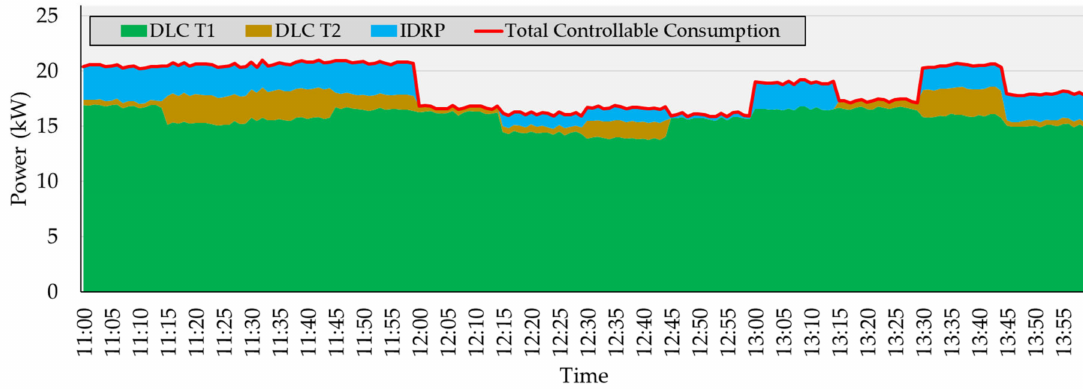
Figure 9. Available Demand response programs during ramp period and event.